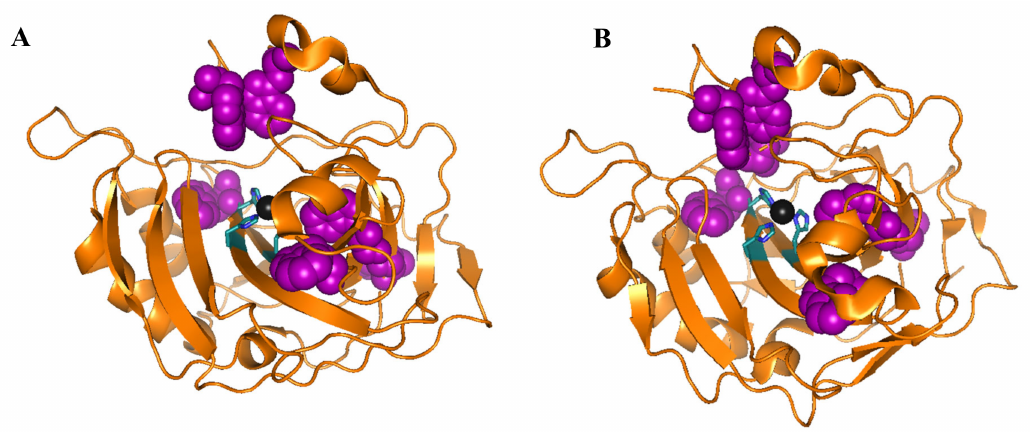
Figure 2. Ribbon structure with highlighted tryptophan side chains in purple for ( A ) hCA I (pdb:2cab) and ( B ) hCA II (wild type) (pdb: 2ili). Zinc ion is shown as a black sphere. Images were prepared